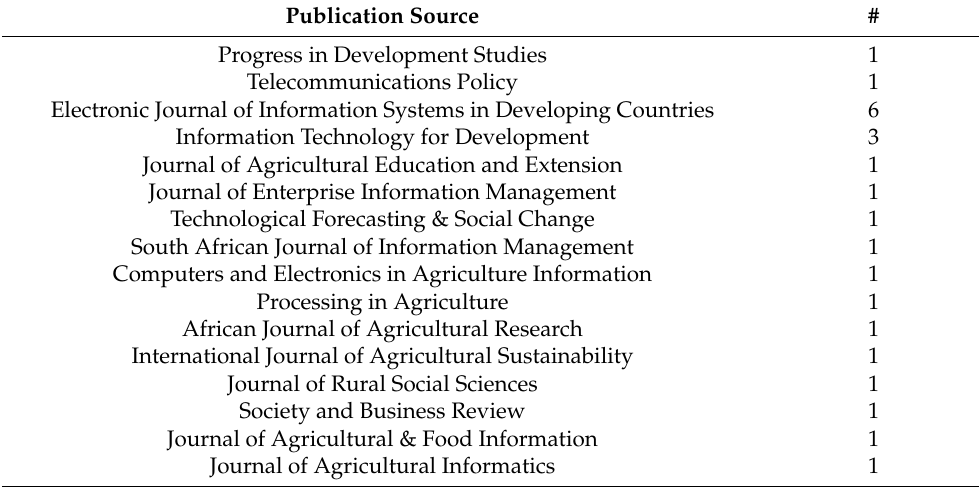
Table 2. Main publication